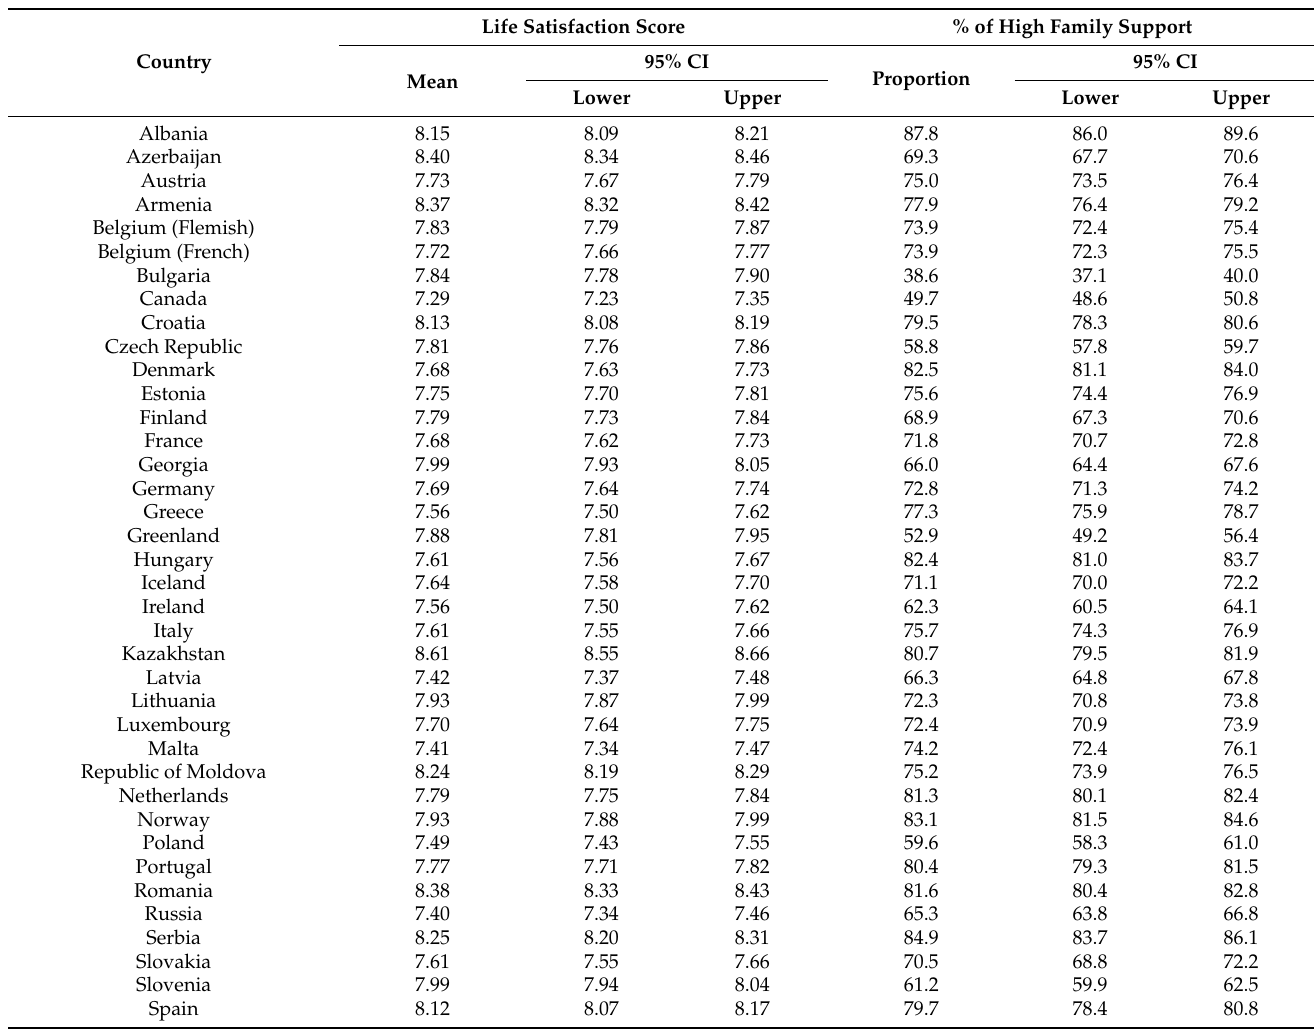
Table 2. Descriptive statistics of life satisfaction score and high family support, by